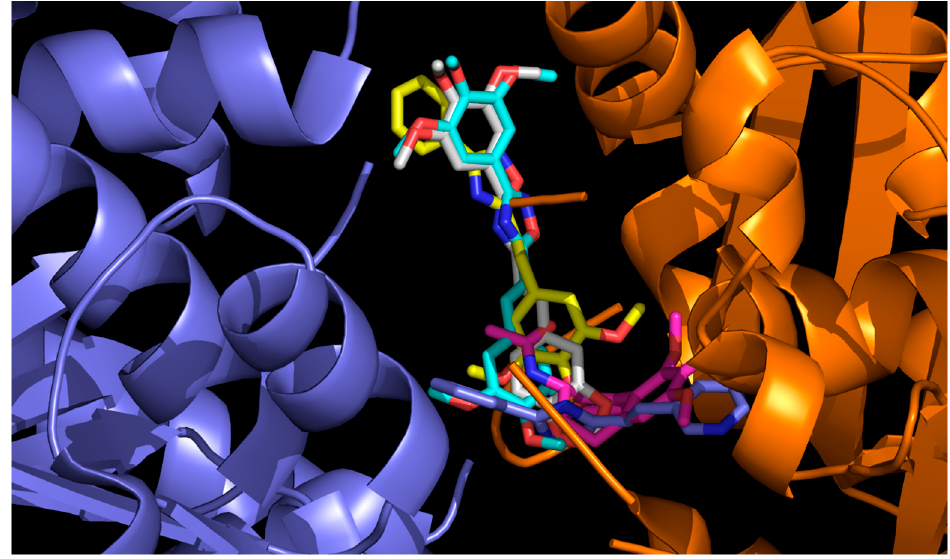
Figure 6. Best docking poses at CBS ( α and β monomers of bovine tubulin in purple and orange, respectively). Colchicine (magenta), 12 (yellow), 15 (purple), 23 (cyan), and 24 (gray).